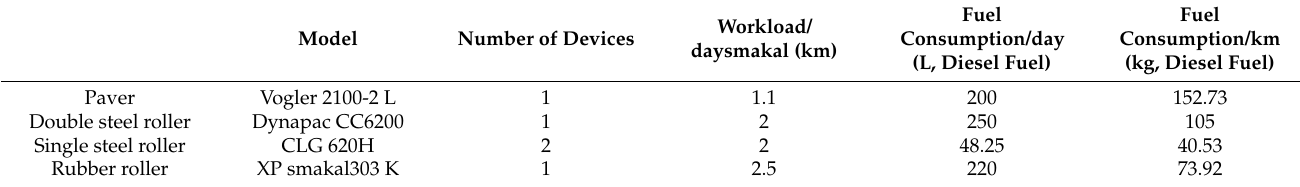
Table 6. Machinery list of paving